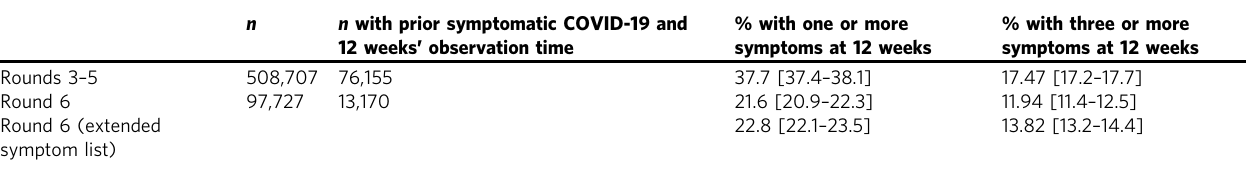
Table 1 Proportions of respondents in (i) rounds 3 – 5 and (ii) round 6 who still reported one or more (or three or more) symptoms 12 weeks after initial symptom onset.